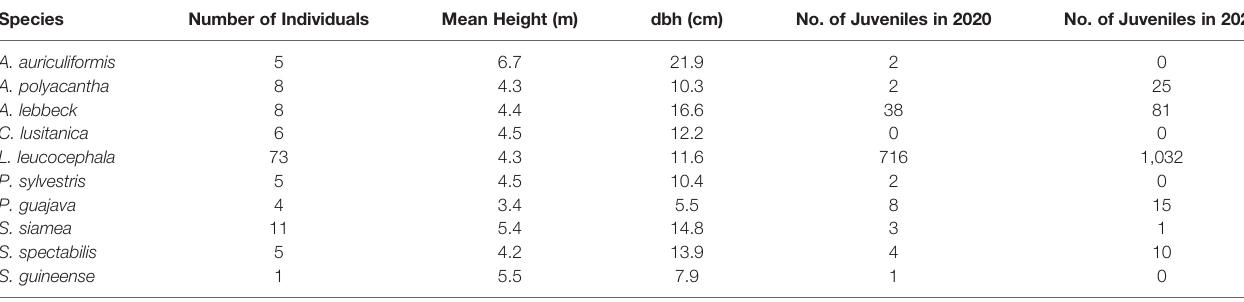
TABLE 1 | Dendrometric characteristics and performance of tree species in the TD 15 years after planting (1.5 ha). Species Number of Individuals Mean Height